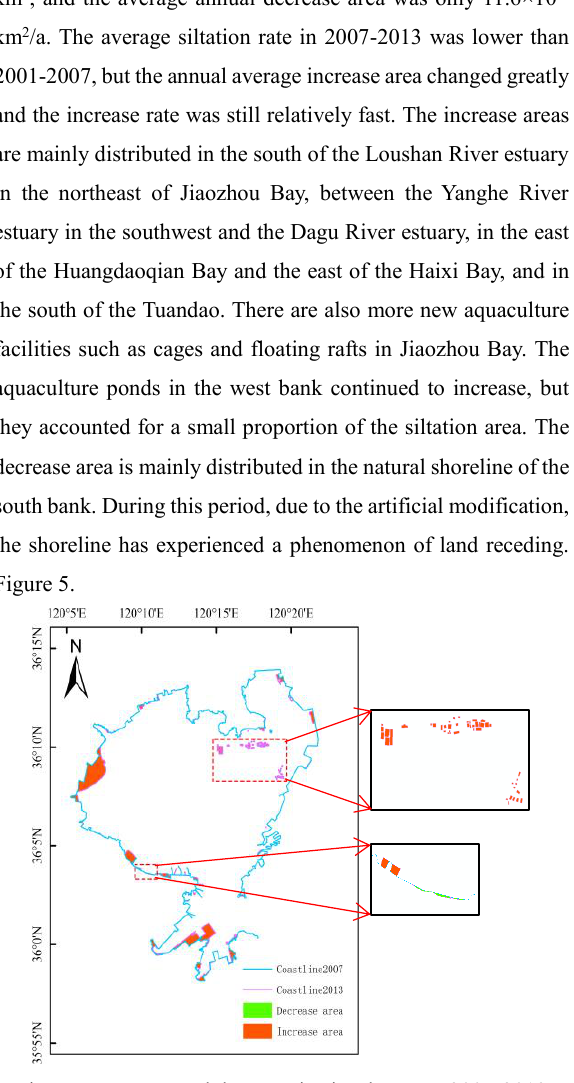
Figure 5 Increase and decrease in Jiaozhou Bay 2007-2013 2013-2017, the area of increase was 1.64 km 2 , the average annual increase area was 0.41 km 2 /a, the decrease area was 1.47 km 2 , and the average annual decrease area was 0.367 km 2 /a. The average siltation rate in 2013-2017 has slowed down significantly compared with the previous two periods, but the relative annual variation during this period is large; the average annual decrease rate has accelerated significantly, reaching 32 times the previous period. The siltation is mainly due to the small increase in aquaculture ponds on the west bank of Jiaozhou Bay and sea reclamation on the eastern side of Huangdaoqian Bay. The decrease in area was mainly due to the reduction of aquaculture ponds on the east coast of Hongdao Island and the cleanup of aquaculture facilities such as cages and floating rafts in Jiaozhou Bay. Figure 6.